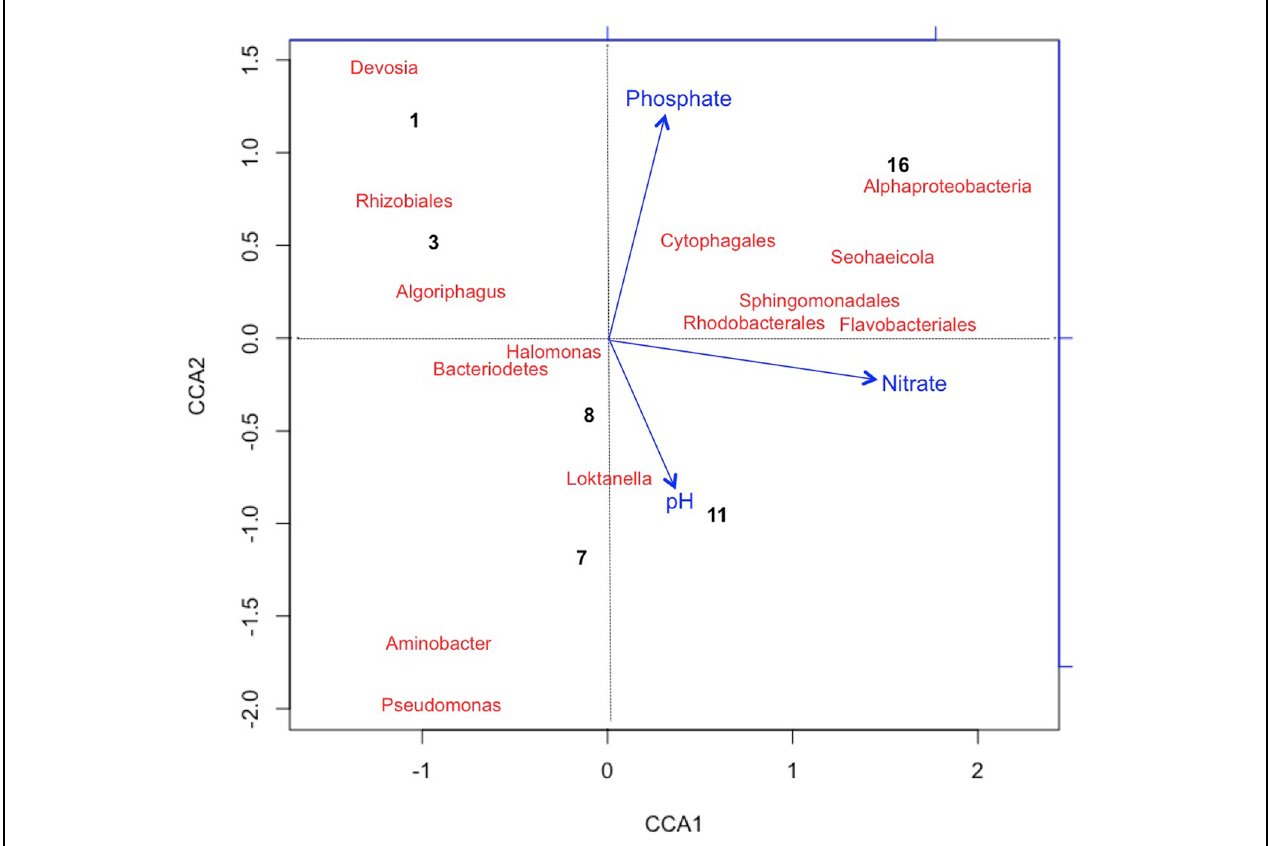
FIGURE 5 | Canonical Correspondence Analysis plotting chemical variables that correlated with variation in Bacterial taxa (with > 2% relative abundance) and sample points. Bacteria generally trended with an increase nitrate toward end of the experiment, possibly due to an increase in nitrifying taxa. Pseudomonas sp. was associated with the early time points (day 1 and 3). CCA1 = 60% and CCA2 =